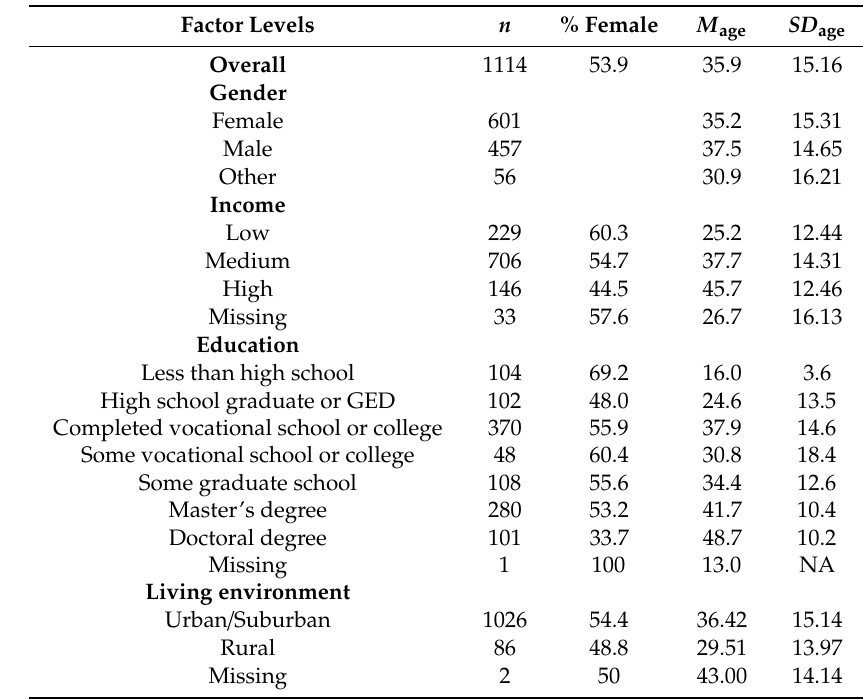
Table 1. Participants’ demographic data ( n = 1114).